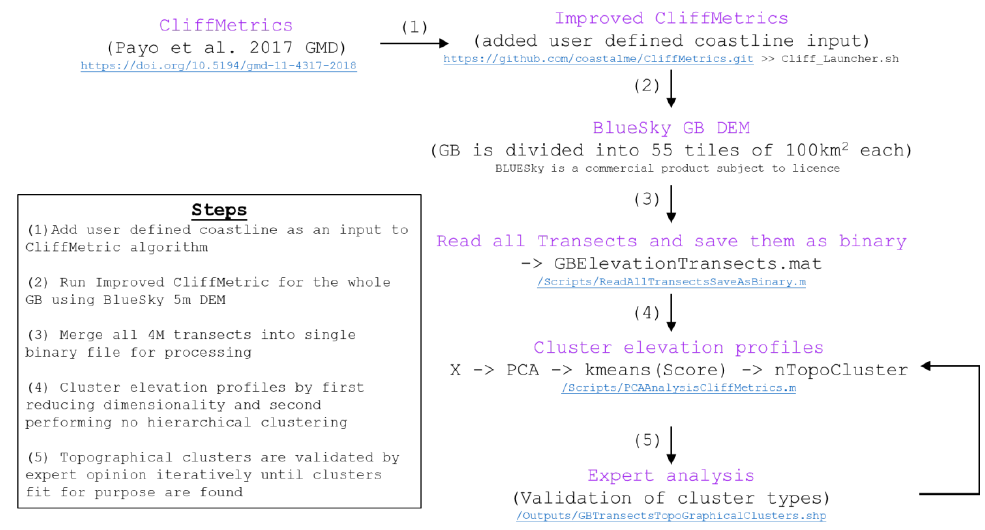
Figure 6. Methodological approach followed to classify the elevation profiles along the Great Britain coastline. The scripts used for the different steps are indicated and included as supplementary information.